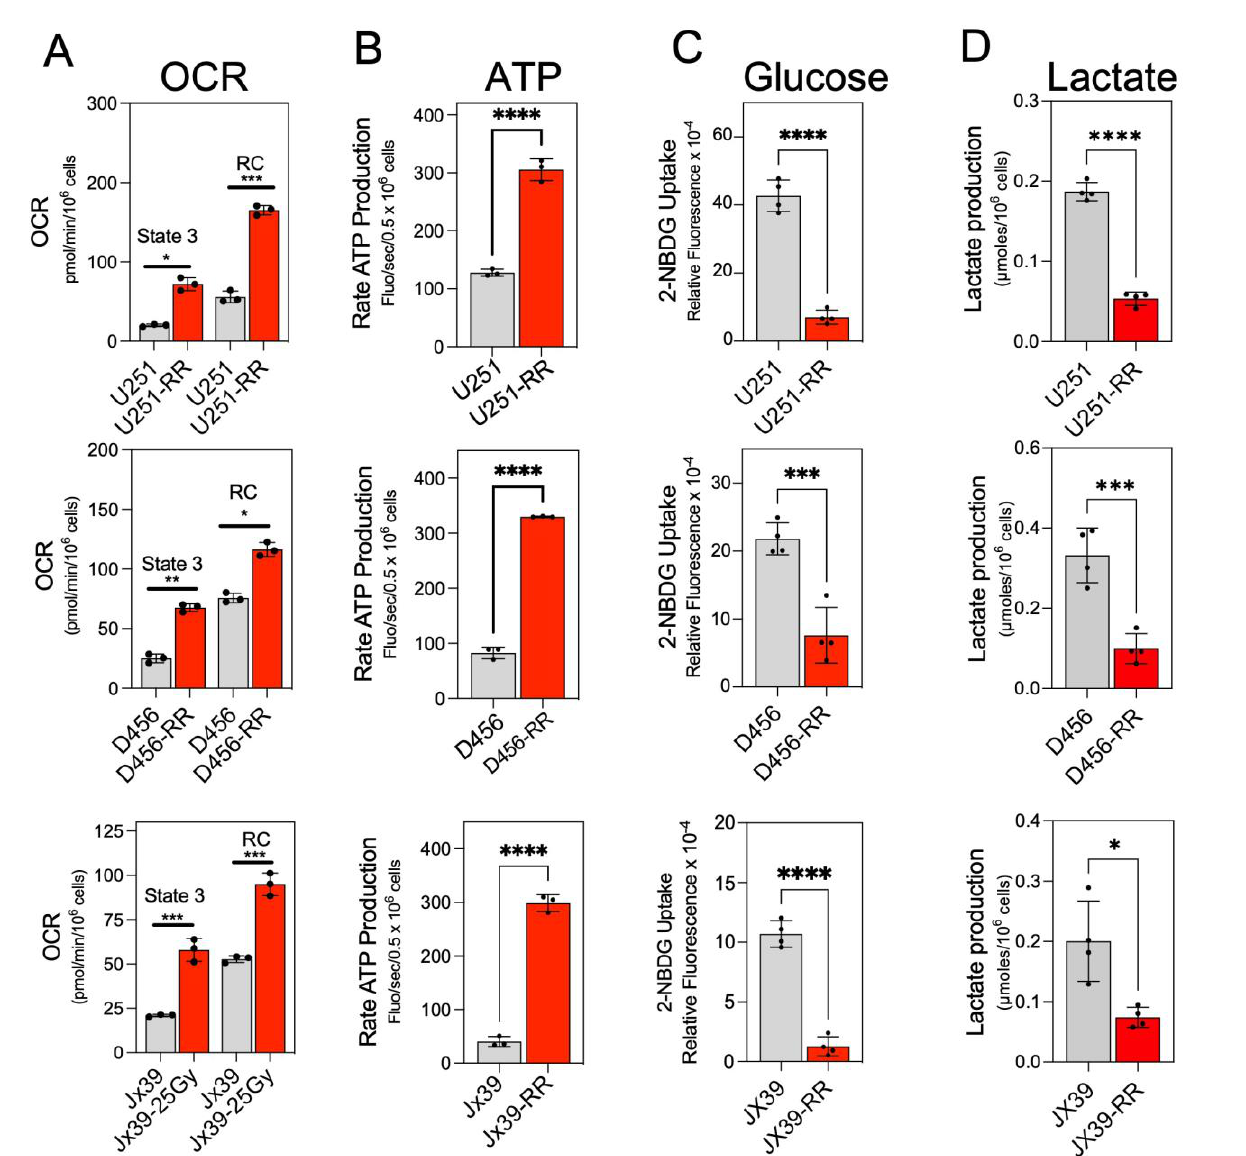
FIGURE 2: Acquired radioresistance in GBM cells is associated with a switch to an OXPHOS phenotype. (A) Quantification of the OCR in radi- osensitive (U251, D456, and Jx39) and isogenic radioresistant (U251-RR, D456-RR, and Jx39-RR) cell lines after the addition of pyruvate/malate and ADP (state 3) and after the subsequent addition of FCCP (reserve capacity). Data are presented as the mean  SEM (n=3). (B) Quantifica- tion of ATP production rate in radiosensitive and radioresistant cell lines, assessed by the reduction of NADP + to NADPH. Data are presented as the mean  SEM (n=3). (C) Quantification of cellular glucose uptake in the radiosensitive and radioresistant cell lines estimated with the non- phosphorylatable fluorescent glucose analogue 2-NBDG. Indicated cells were incubated with 100  M 2-NBDG for 20 min, and 2-NBDG fluores- cence was measured in a microplate fluorometer. Data are presented as the mean ± SEM (n= 4). (D) Quantification of extracellular lactate concentrations in cultures of the radiosensitive and radioresistant cell lines. Data are presented as the mean ± SEM (n= 4). OCR, oxygen con- sumption rate; Res capacity, reserve capacity; 2-NBDG, 2-(N-(7-nitrobenz-2-oxa-1,3-diazol-4-yl)amino)-2-deoxyglucose. p < 0.05 (*), p < 0.01 (**), p < 0.001 (***), and p < 0.0001 (****), calculated by Student